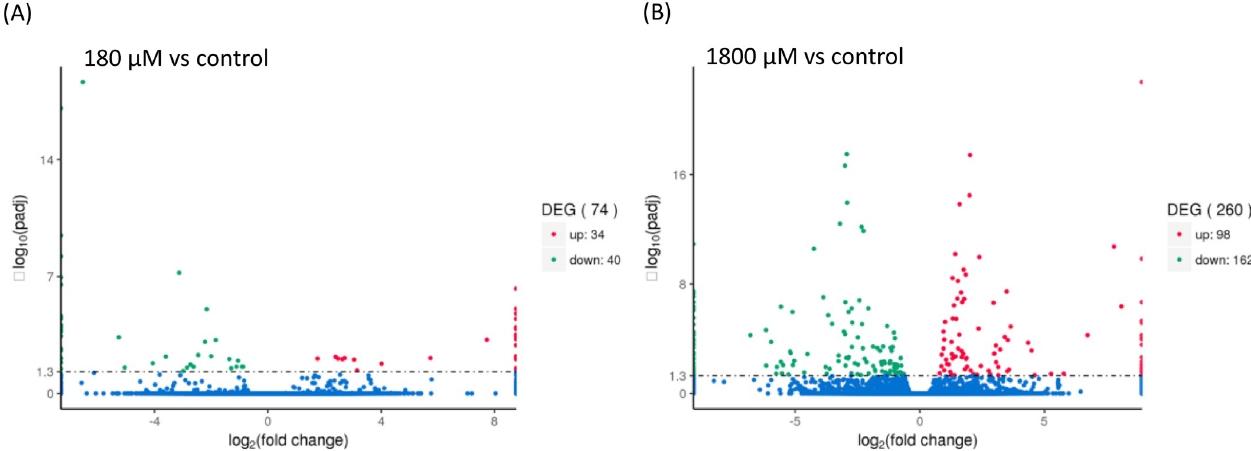
Fig 3. Volcano plots of differentially expressed genes associated with H 2 O 2 treatments. The X axis represents fold change, while the Y axis indicates the significance of differential expression. (A) 180 μ M vs control. (B) 1800 μ M vs control.